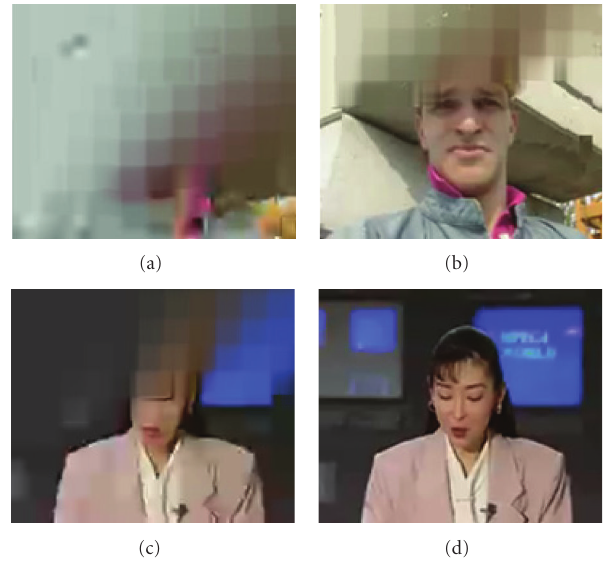
Figure 6: Example of visual results obtained in simulation: non- adapted (left) versus adapted